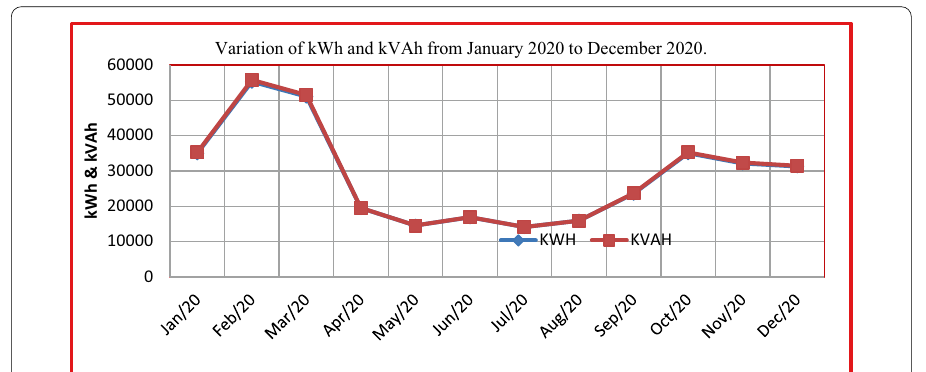
Fig. 24 kWh and kVAh graphs of SUES Substation of calendar year 2020